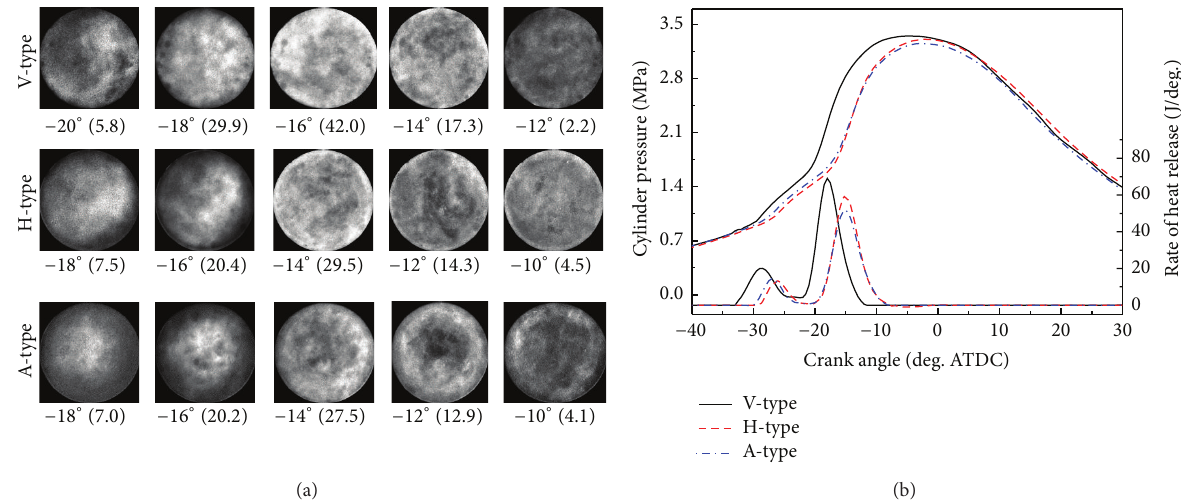
Figure 8: Chemiluminescence images, cylinder pressure, and rate of heat release with various piston bowl geometries at 𝑇 85 ∘ C. The number below each image is the crank angle and light intensity [63].